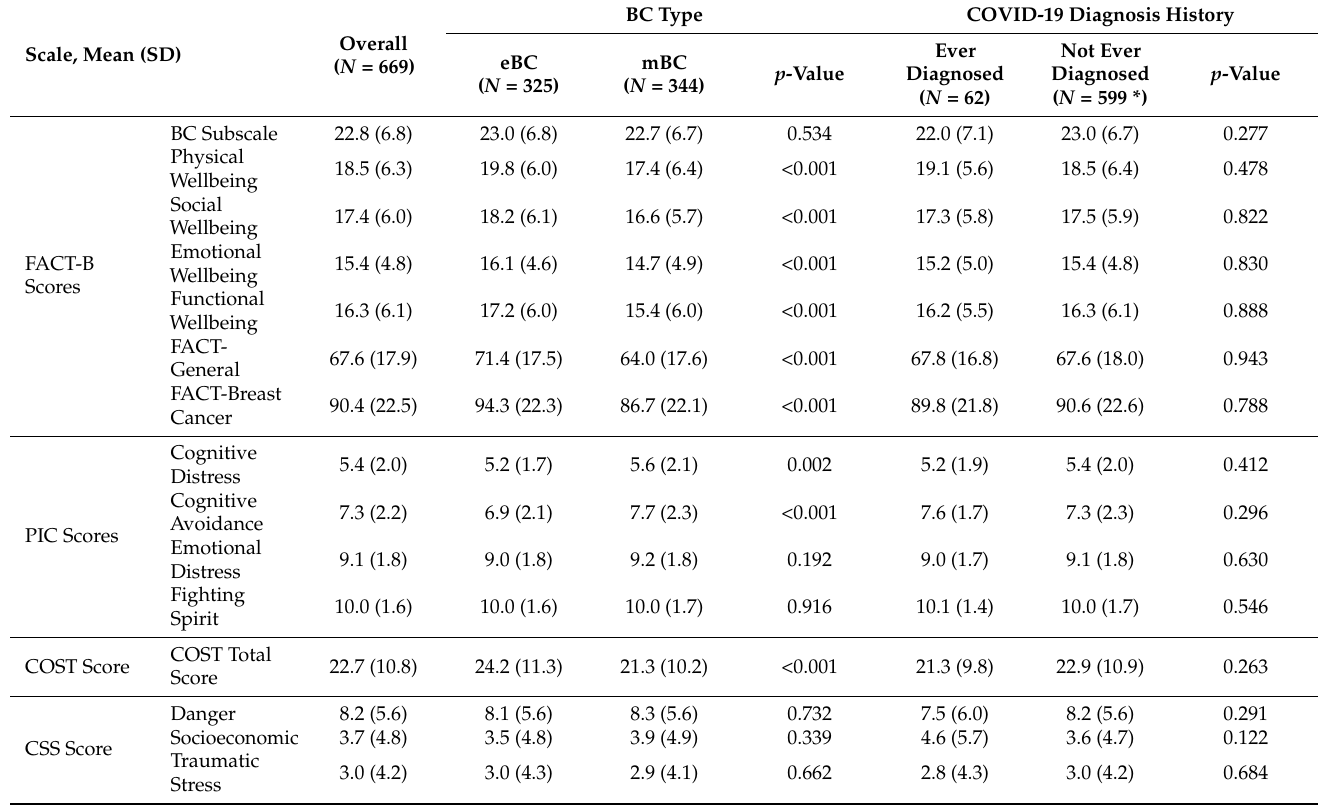
Table 2. Mean Scores of Psychosocial Wellbeing Measures (FACT-B, PIC, COST,